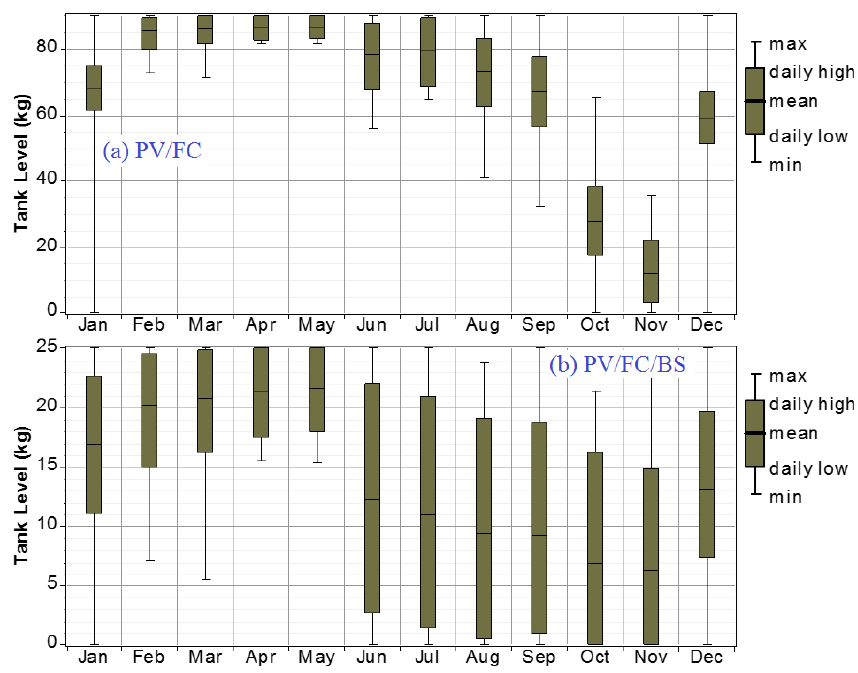
Figure 14. Monthly statistics of the hydrogen tank.